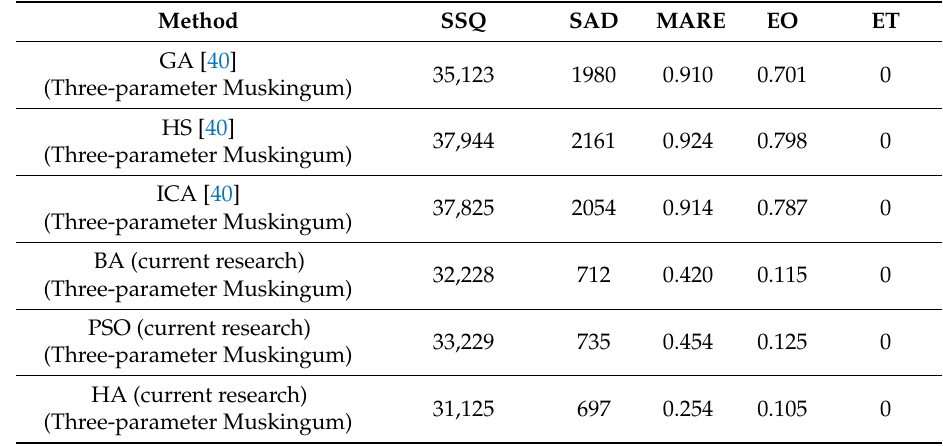
Table 10. Comparison of results for Karahan flood.